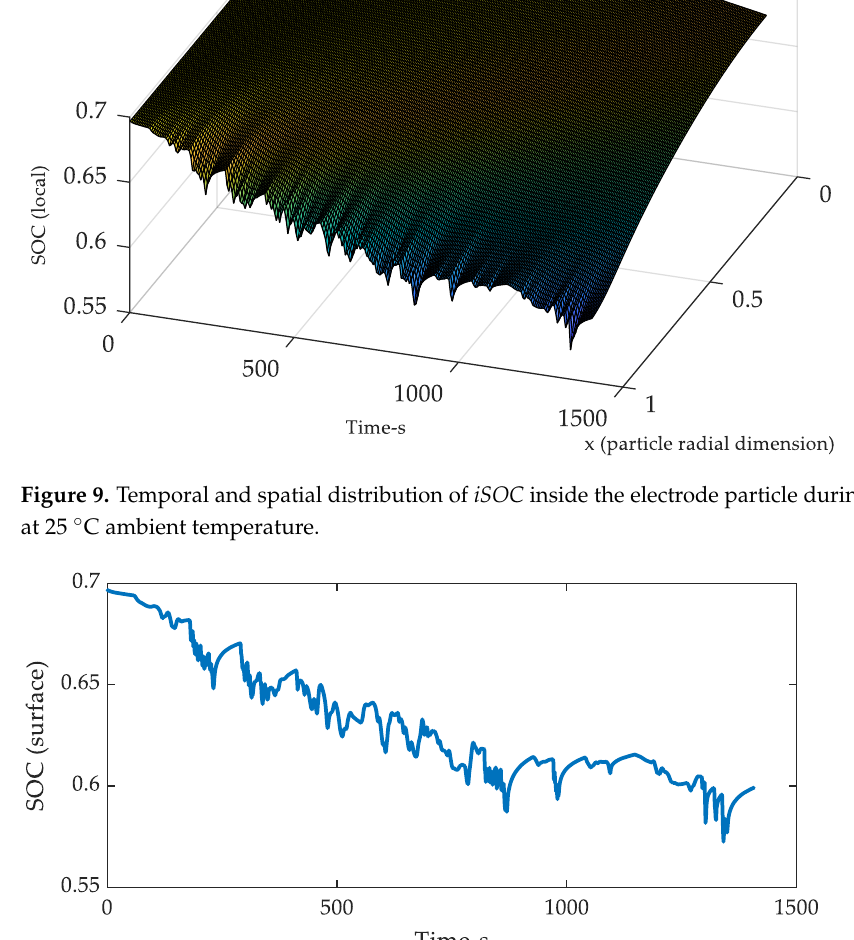
Figure 11. Quantitative characterization curves of three types of polarization voltage based on LDM. 3.4. Online Polarization Voltage Characterization Using a Hardware Platform To realize the online quantitative characterization of the polarization voltage drop based on LDM, the model parameters at different SOC levels need to be identified offline in advance. Discharge pulses were applied to the battery at 25 °C at different SOC levels and rest for 2 h after each discharge pulse, and current versus voltage data were recorded throughout. The SOC levels were selected as 98, 95, 90, 80, 70, 60, 50, 40%, 30, 20, 10, 8, 5, 3, 1 and 0%. A portion of the data before and after each discharge pulse, containing the zero-state response and zero-input response phases, was intercepted as input data for the parameter identification algorithm. A 9th order polynomial was used to fit the parameter points. The fitting curves for three model parameters are shown in Figures 12 – 14. Figure 12. Variation curve of diffusion time constant τ with SOC.